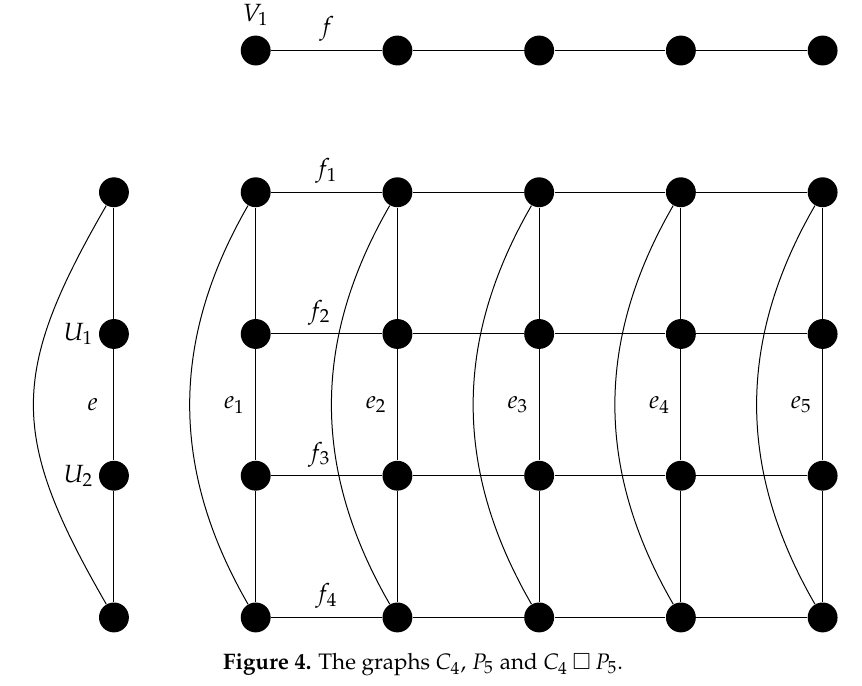
Figure 4. The graphs C 4 , P 5 and C 4 (cid:3) P 5 .